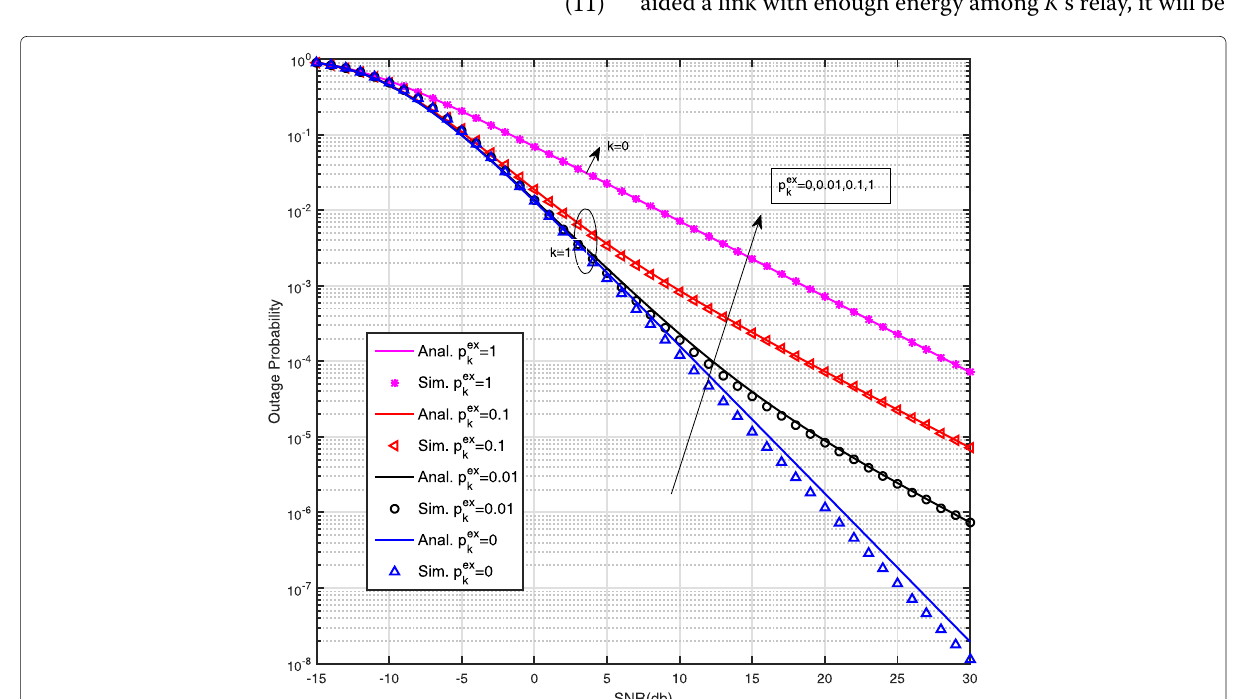
= 1, m = 1, p ex = { 0,0.01,0.1,1 } , k = r k d 1 r k